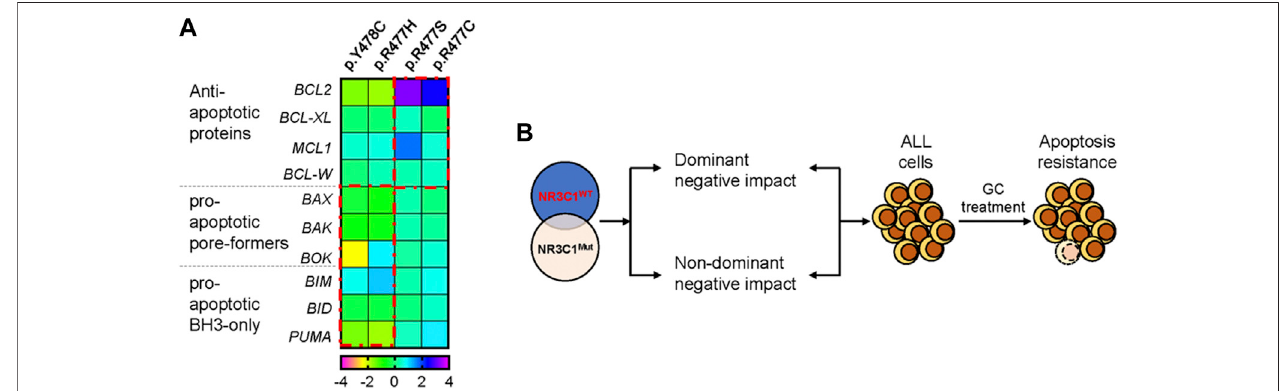
FIGURE 4 | NR3C1 mutations contribute to GC resistance by dominant-negative and non-dominant-negative regulatory effects. (A) The expression of apoptosis- related genes in NR3C1 mutants was determined by quantitative PCR. The expression levels of anti-apoptotic genes ( BCL2, BCL-XL, MCL1, and BCL-W ) were up- regulatedinNR3C1mutants (p.R477C andR477S)byadominant-negativeregulatory effect.Pro-apoptotic genes( BAX,BAK,BOK,BIM,BID, and PUMA )weredown- regulated in NR3C1 mutants (p.R477H andp. Y478C) by non-dominant-negative regulation. (B) Model of the mechanism underlying GC resistance caused by NR3C1